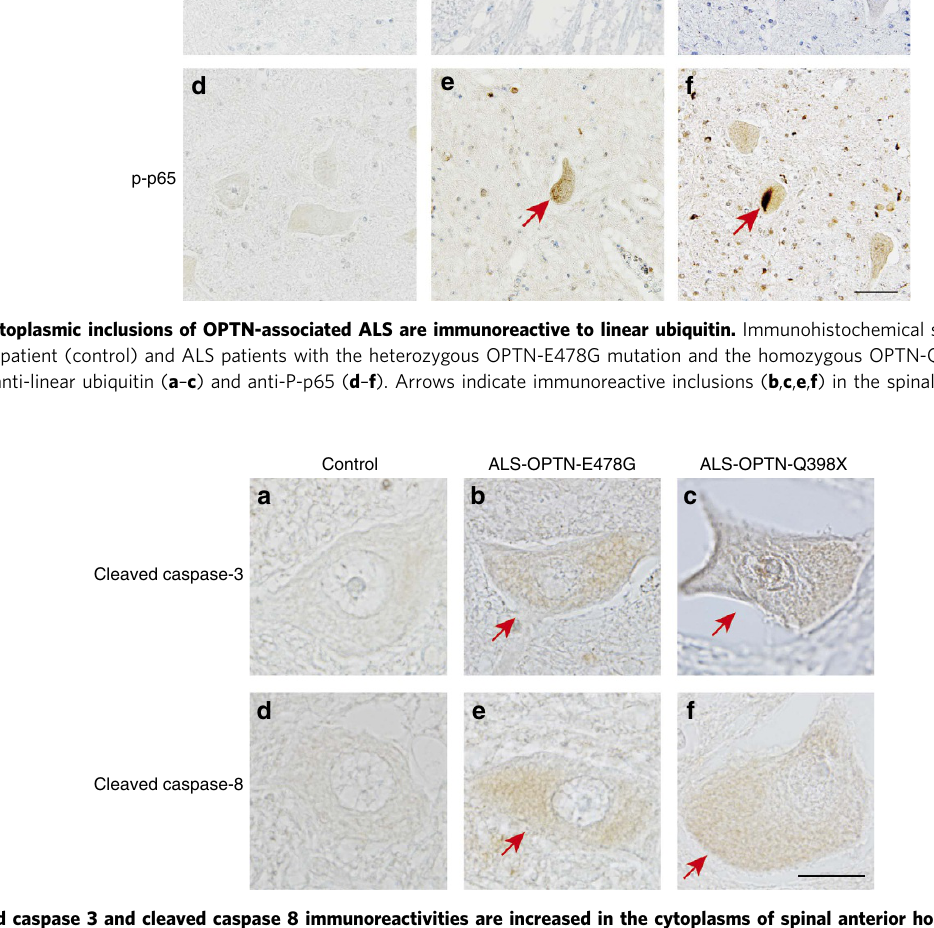
Figure 7 | Cleaved caspase 3 and cleaved caspase 8 immunoreactivities are increased in the cytoplasms of spinal anterior horn cells from OPTN-associated ALS cases. Immunohistochemical staining of specimens from a control subject and ALS patients with the heterozygous OPTN-E478G mutation and with the homozygous OPTN-Q398X mutation were performed using anti-cleaved caspase 3 ( a – c ) and anti-cleaved caspase 8 ( d – f ). Faintly increased diffuse cytoplasmic immunoreactivities of the spinal anterior horn cells from the OPTN-associated ALS patients are indicated by arrows ( b , c , e , f ). Scale bar, 20 m